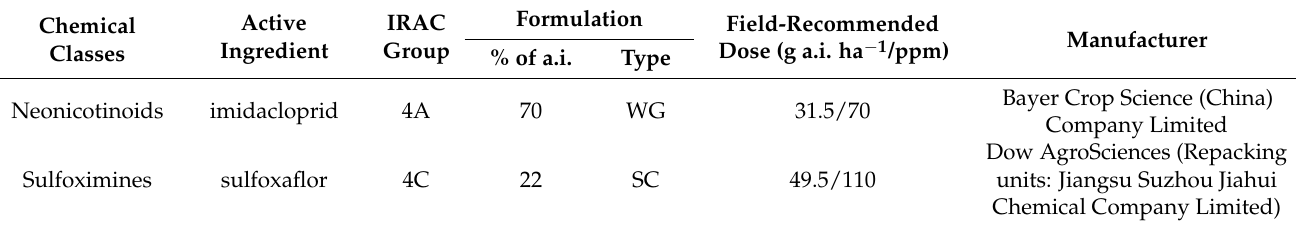
Table 1. Formulation, field-recommended concentration and manufacturer of two insecticides tested for their side effects on Harmonia axyridis